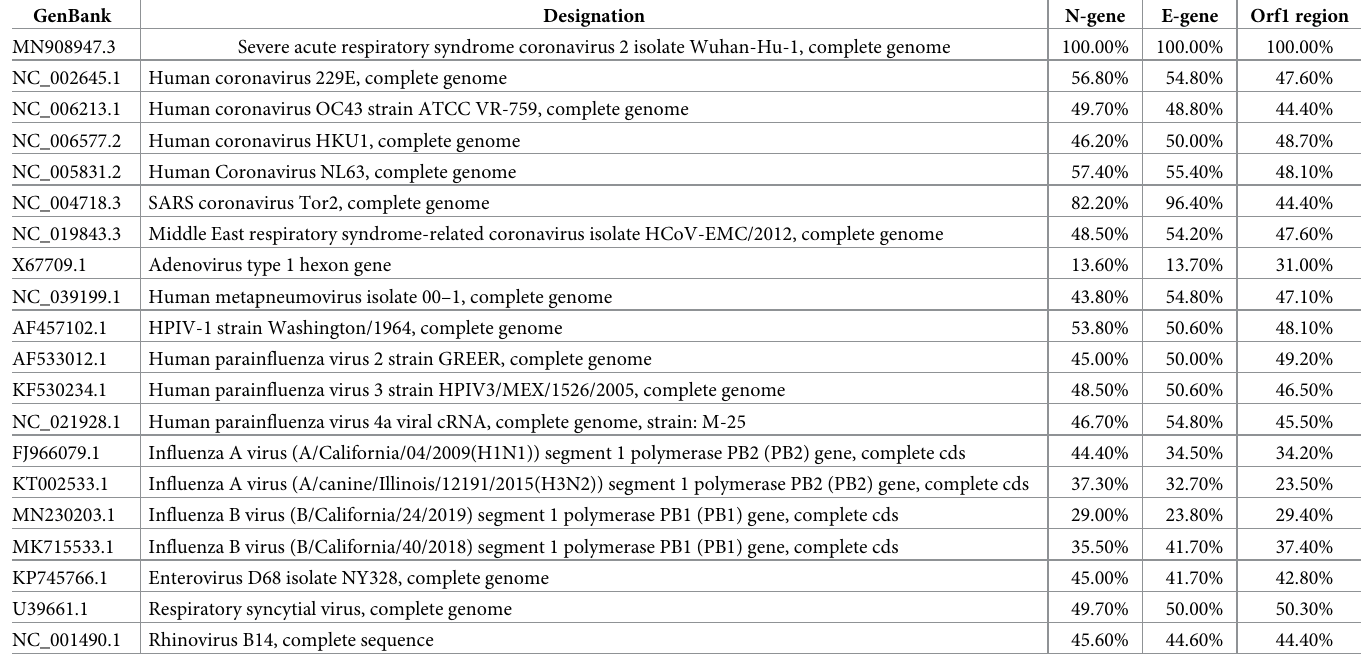
Table 4. In Silico